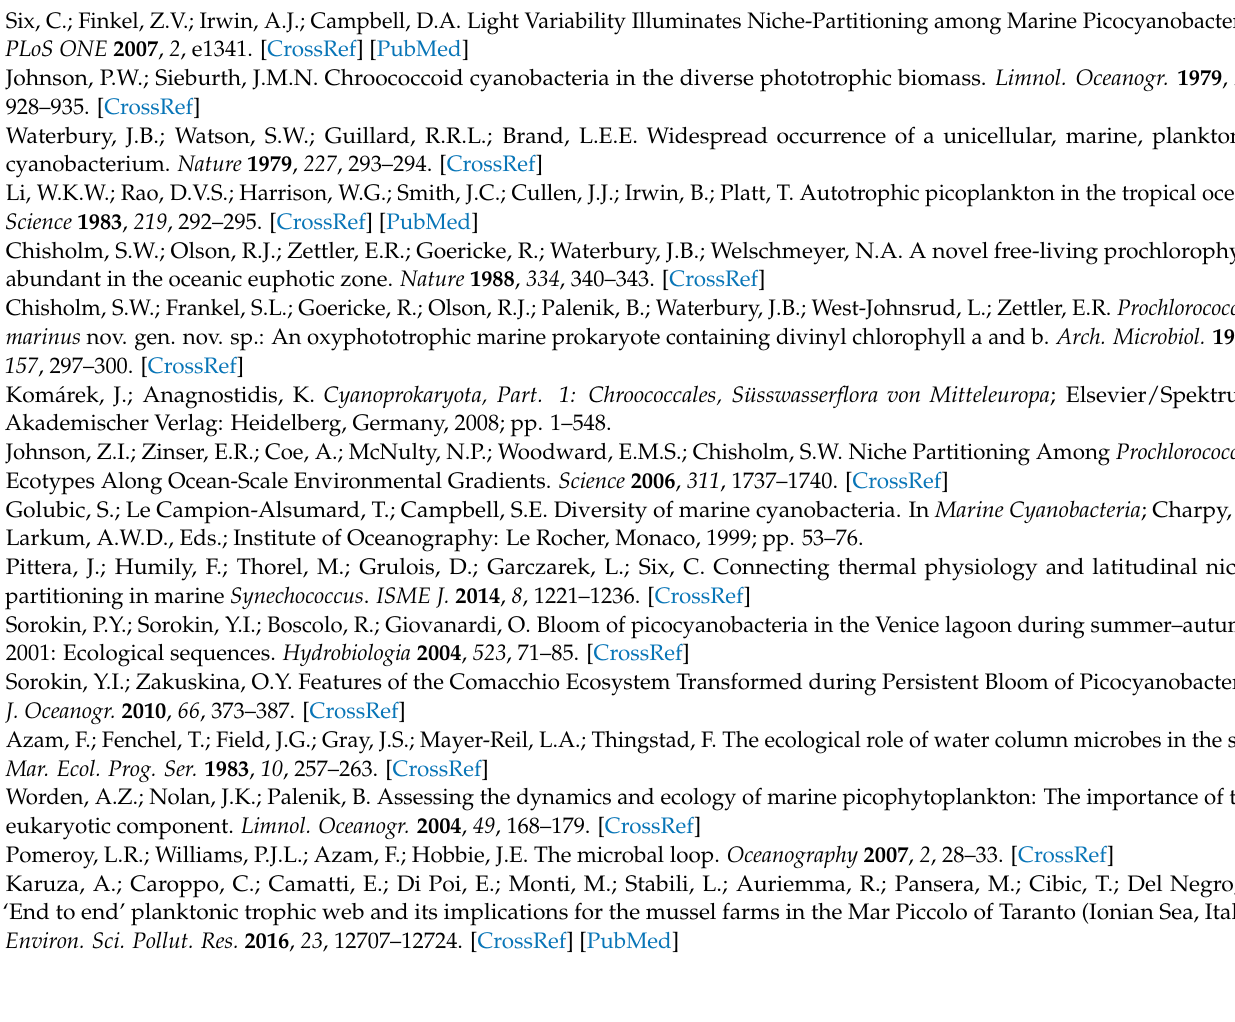
Table S1: Metabolites identified in the extracts using GC-HRMS, Table S2: lists of all the signifi- cant ( P -values < 0.05) characteristics distinguishing methanolic from aqueous extracts obtained and annotated by